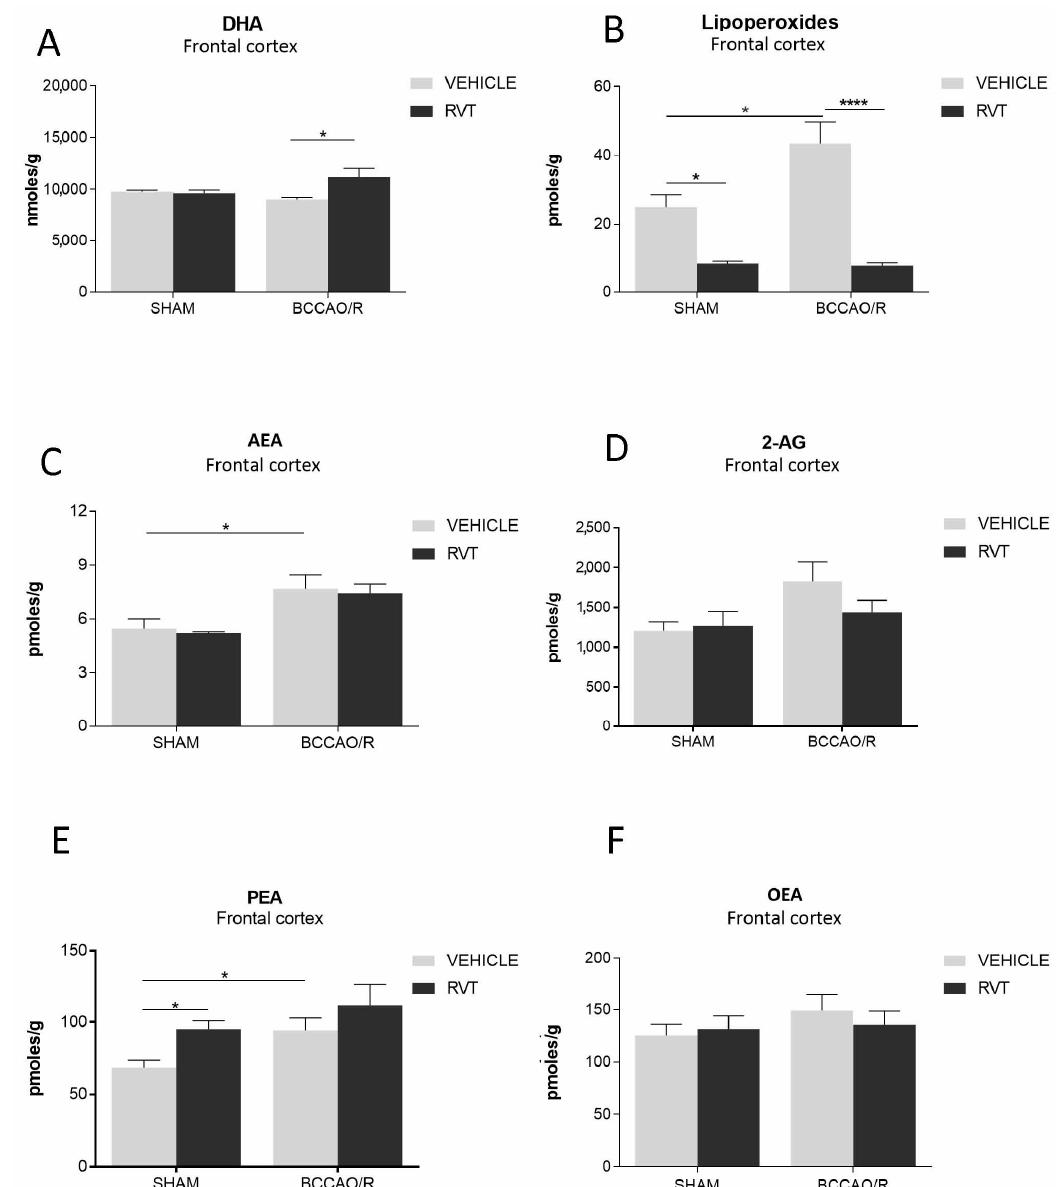
Figure 1. High performance liquid chromatography (HPLC) analysis of frontal cortex of sham-operated and bilateral common carotid artery occlusion followed by reperfusion (BCCAO/R) vehicle-treated and RVT pre-treated rats, respectively. ( A ) Docosahexaenoic acid (DHA), ( B ) lipoperoxides, ( C ) arachidonoyl ethanolamide (AEA), ( D ) 2-arachidonoylglycerol (2-AG) ( E ) palmitoylethanolamide (PEA) and ( F ) oleoylethanolamide (OEA) concentrations are reported as the mean values of 12 vehicle, either sham or BCCAO/R, and 12 RVT pre-treated, either sham or BCCAO/R, rats. Error bars depict the standard error of the mean (S.E.M.). Asterisks denote significant differences. Two-way ANOVA with the Bonferroni’s test for post hoc analyses was applied to evaluate statistical differences between groups. * p < 0.05; **** p < 0.0001 (see Table 1 for F - and p -values relevant to the effects of BCCAO/R and RVT pre-treatment and to the interaction between them).